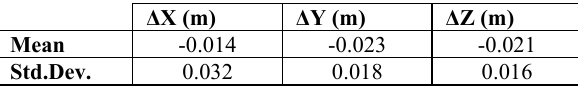
Table 6 Comparison between the coordinates of the 92 camera positions estimated with the standard processing (11 GCPs) and the coordinates of the same camera position estimated with the PPK processing (1 GCP).